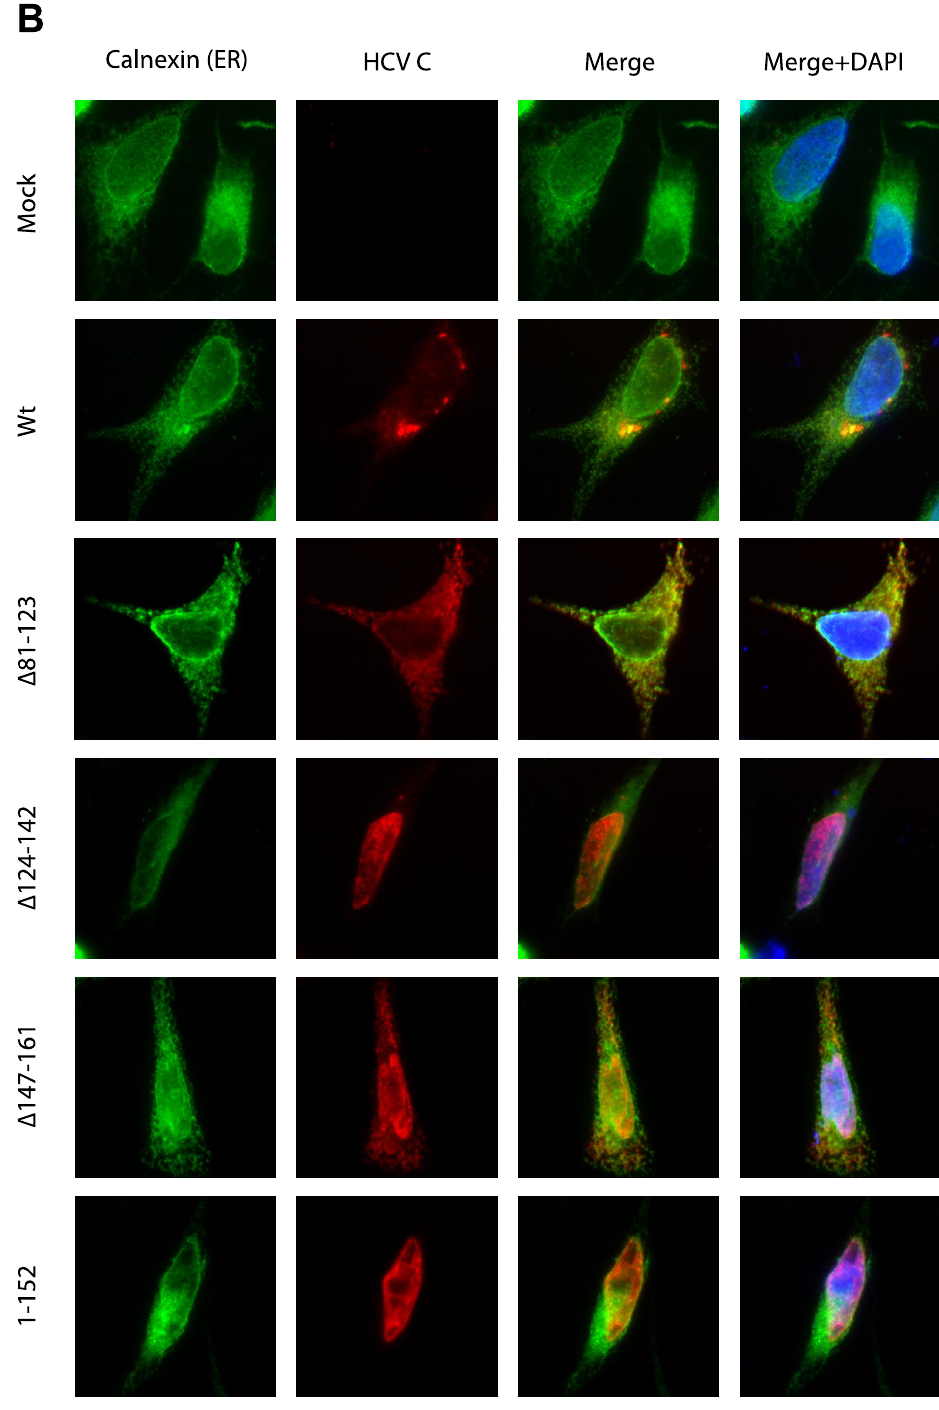
Figure 3. Intracellular localization of the C mutant proteins. HeLa T-REx cells transfected with plasmid encoding either the wild-type (wt) or selected C mutant proteins. ( A ) At 48 h post-transfection, cells were fixed in acetone/methanol and labeled with the anti-HCV C and anti-ADFP (a cellular marker for lipid droplet), and were analyzed by indirect immunofluorescence assay. Nuclei were visualized after staining with DAPI. ( B ) The C protein distribution in ER or nucleus was detected in the C deletion mutant protein ∆ 81–123, ∆ 124–142, ∆ 147–161 and 1–152 expressing cells. Cells were stained with the anti-HCV C (red) and anti-calnexin (ER marker) green antibodies. Nuclei were visualized after staining with